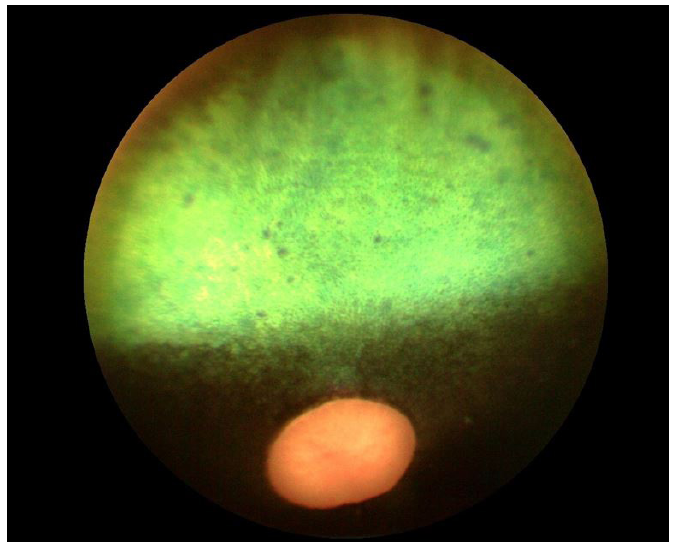
Figure 1. Digital fundscopy showing no morphological changes in the